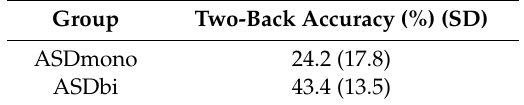
Table 6. Groups’ mean composite accuracy scores (%) in the two-back task. Group